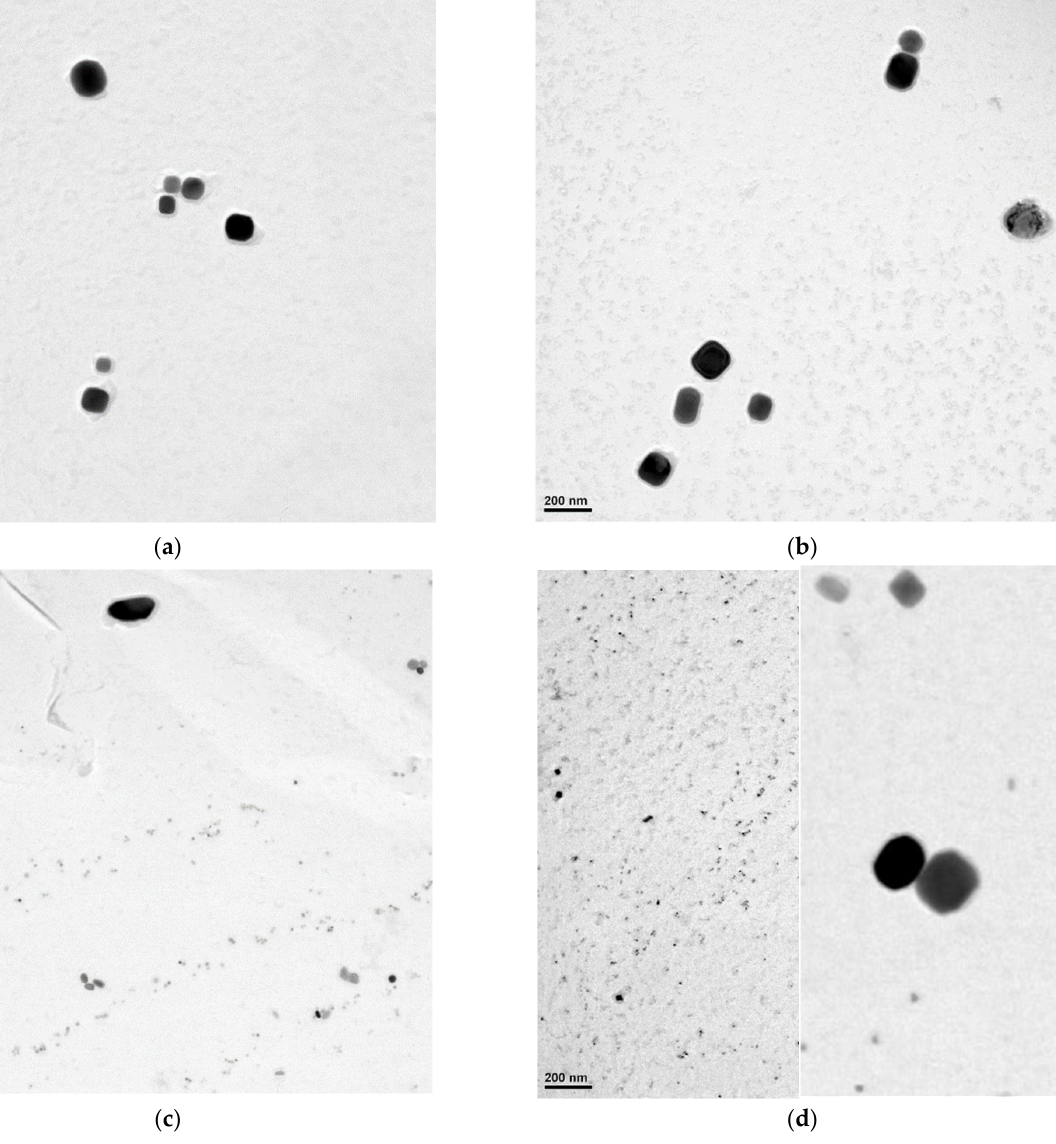
Figure 17. Summary of all precipitate images for each variant V1 to V4. Images were selected that showed examples of precipitates of all observed sizes. For sample V4, it was not possible to capture different-size precipitates in one image; therefore, two images with the same scale are presented. ( a ) V1, ( b ) V2, ( c ) V3, and ( d ) V4.